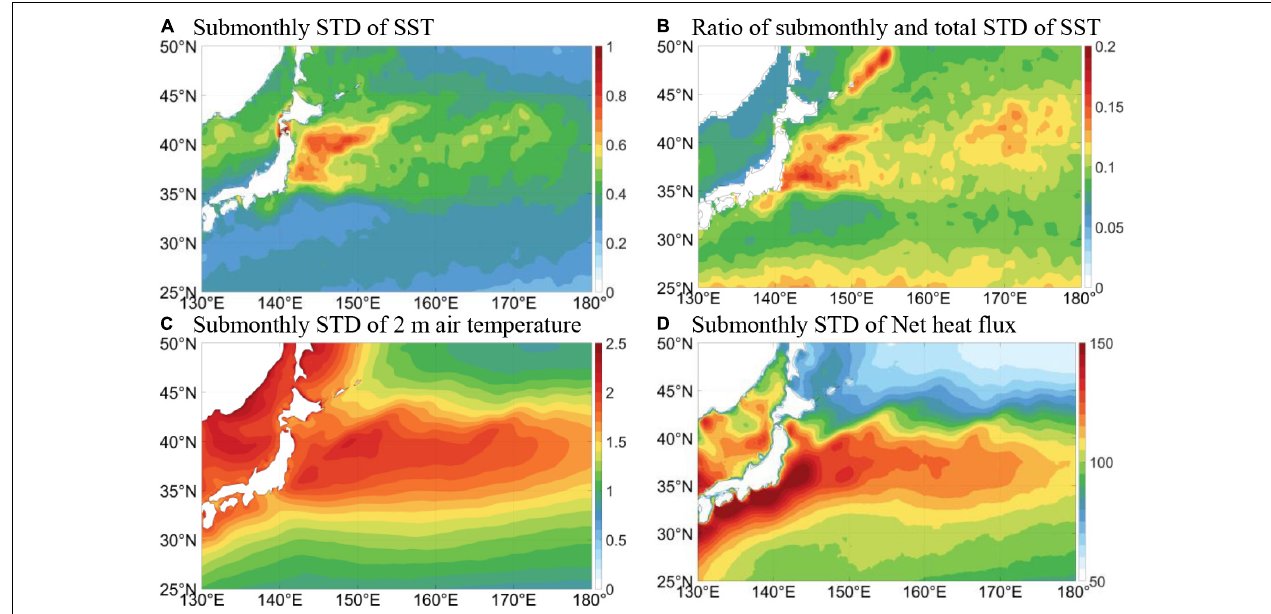
FIGURE 1 | (A) Submonthly standard deviation of (2–30 days) SST ( ◦ C). (B) Ratio of submonthly and total standard deviation of SST. (C) Submonthly standard deviation of 2 m air temperature ( ◦ C). (D) Submonthly standard deviation of surface net upward heat flux (W/m 2 ). All figures are based on ERA5 data in